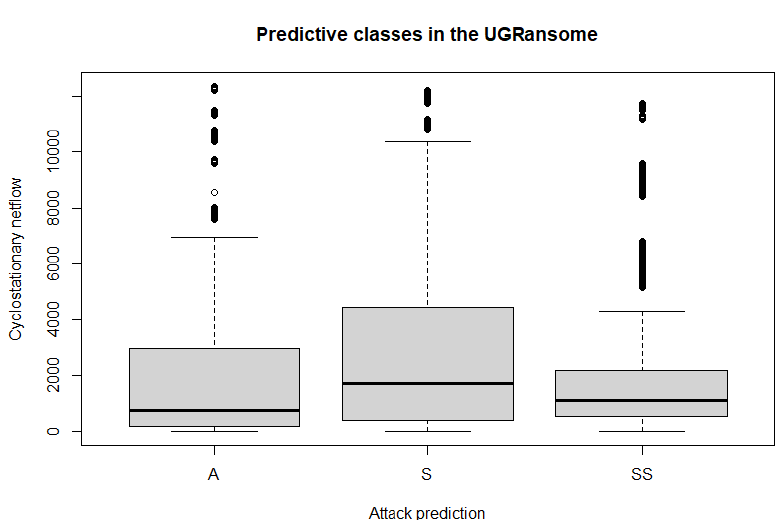
Figure 24. The proportion of signature (S) malware types in the UGRansome dataset. This proportion represents normal attacks because it incorporates threats that match well-known malware signatures. The abnormal attacks are recorded in the anomaly (A) and synthetic signature (SS)